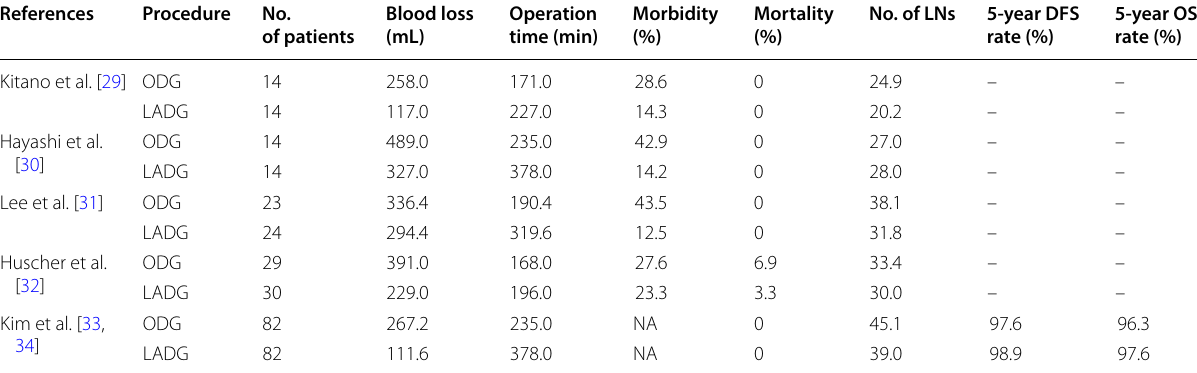
– no data available, ODG open distal gastrectomy, LADG laparoscopy-assisted distal gastrectomy, LNs lymph nodes, DFS disease-free survival, NA not applicable